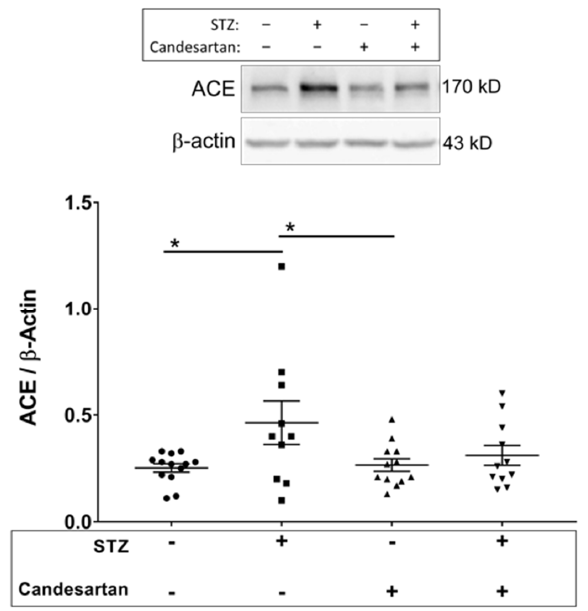
Figure 2. Retinal tissue protein levels (Western blot data; normalized to β-actin) of angiotensin converting enzyme (ACE) in the four groups of rats: untreated non-diabetic controls, untreated STZ, candesartan-treated non-diabetic controls, and candesartan-treated STZ. ACE levels were increased in the diabetic rats, but only in the absence of candesartan treatment. N = 10–13 per group, * p < 0.05 between indicated groups.